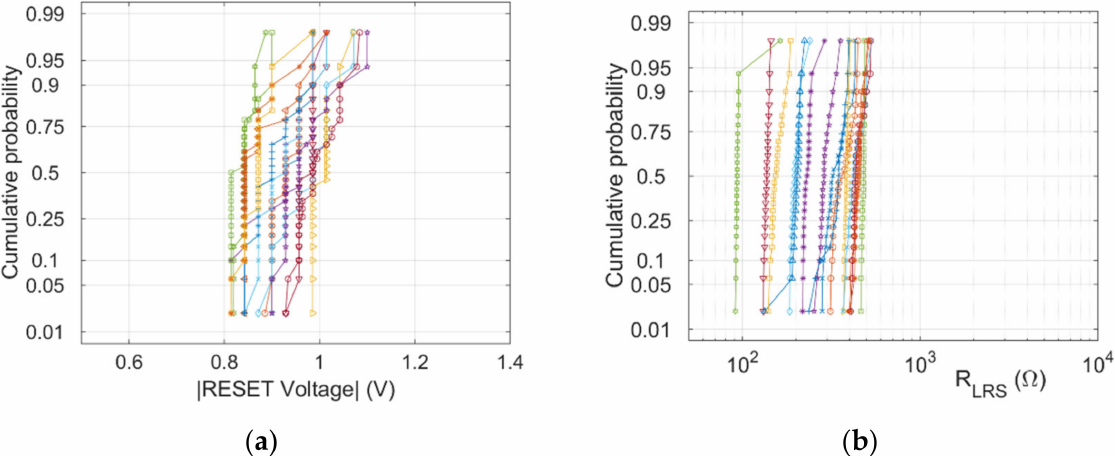
Figure 12. Cumulative probability obtained from 15 different single devices (color lines identify each device) corresponding to 25 DC cycles: ( a ) RESET voltage ( V RESET ); ( b ) Resistance in the LRS ( R LRS ).